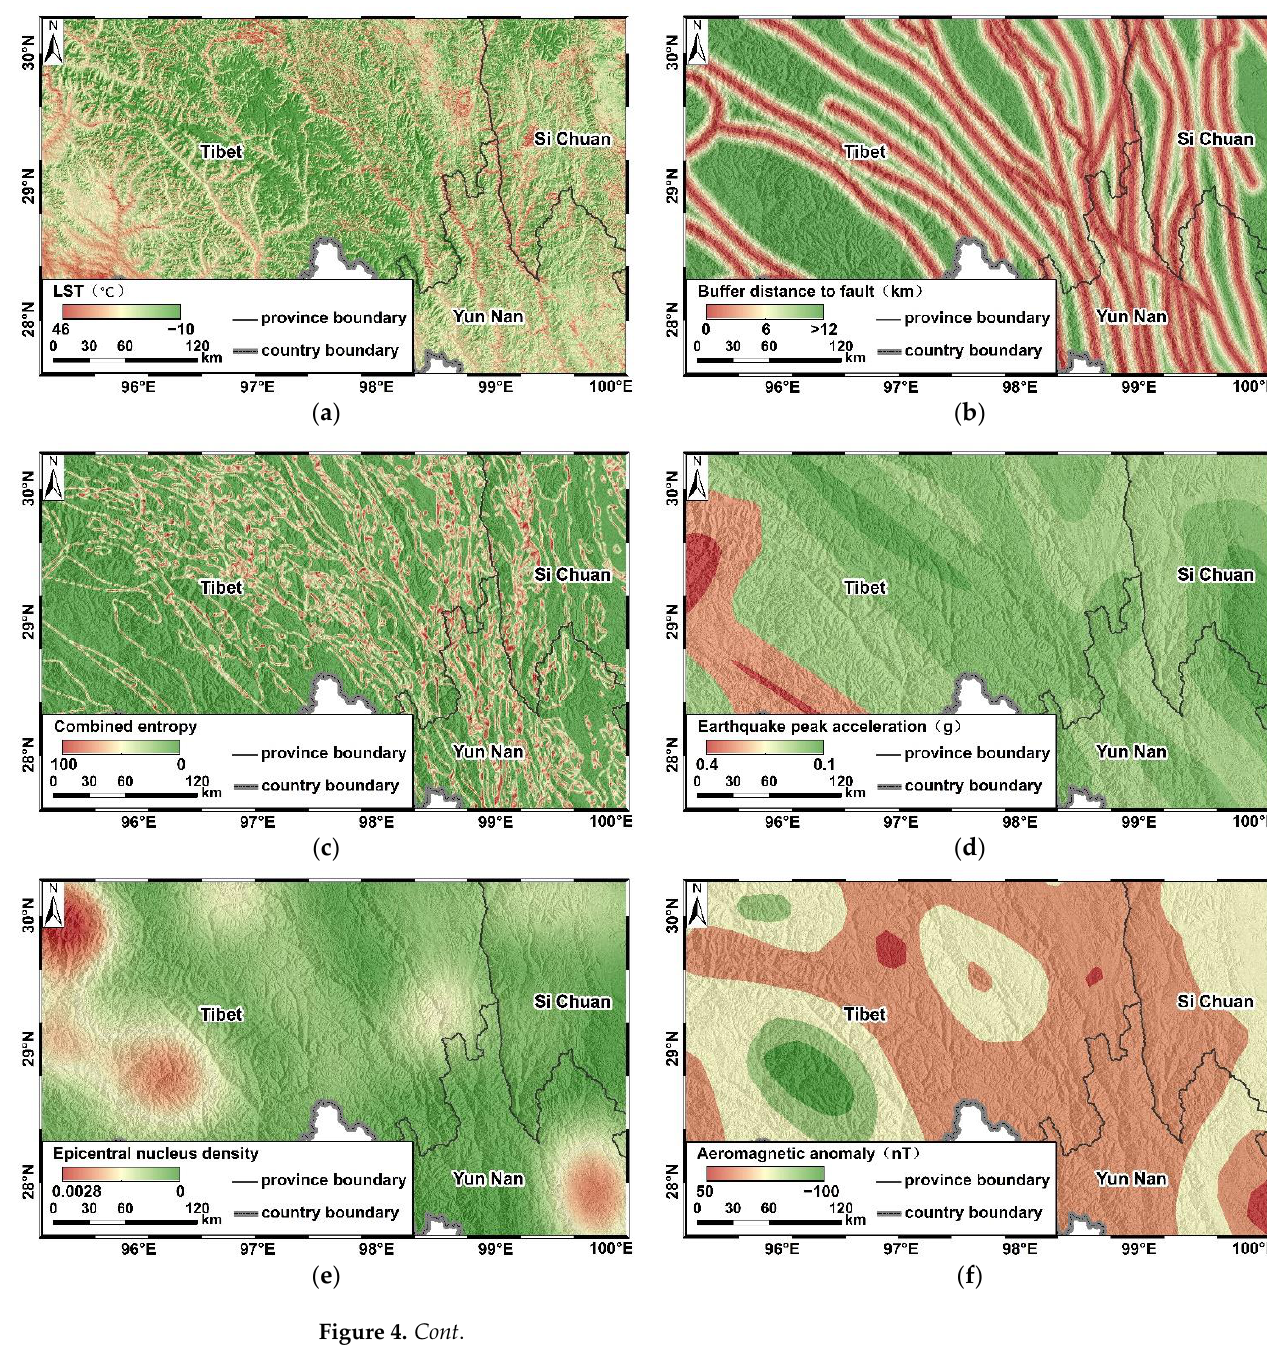
Figure 3. Heat map of the coefficients of correlation between environmental variables. (* means the spearman coefficient is greater than or equal to 0.75) Finally, 12 variables were obtained (Figure 4).